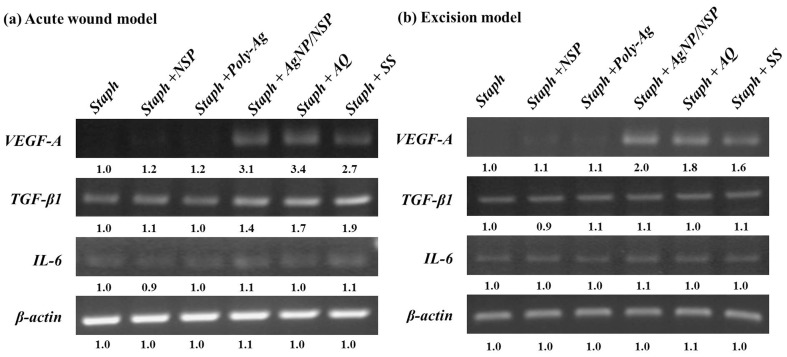
mRNA levels of VEGF-A, TGF-β1 and IL-6 in different treatment groups during wound healing.AgNP/NSP treatment also modulates the expression of cytokine mRNAs in wounded skin. The levels of VEGF-A, TGF-β1 and IL-6 mRNA expression from mice of different treatment groups in both acute thermal injury at day 7 (a) and excision wound at day 15 (b) were examined by RT-PCR. Relative band intensities of different groups were calculated by a densitometer and are demonstrated by the values under the bands. The data shown are representative of three independent experiments.